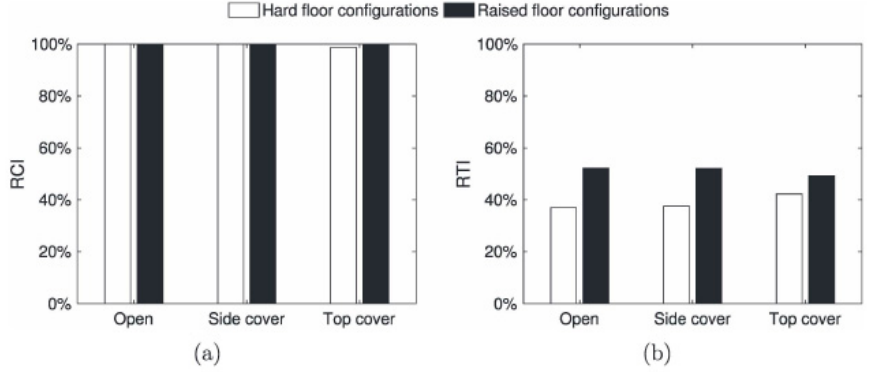
Figure 9. ( a ) Rack Cooling Index (RCI) and ( b ) Return Temperature Index (RTI) for all setups.